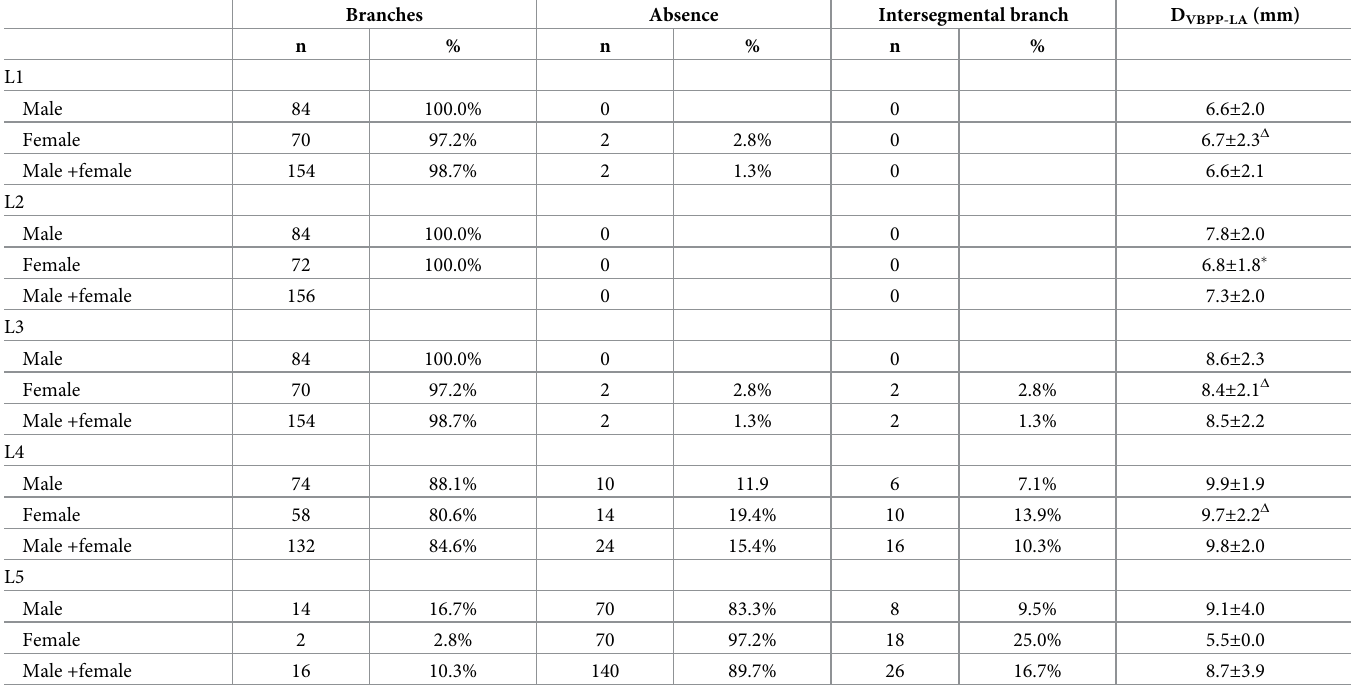
Table 1. Basic data on LAs and D VBPP-LA in